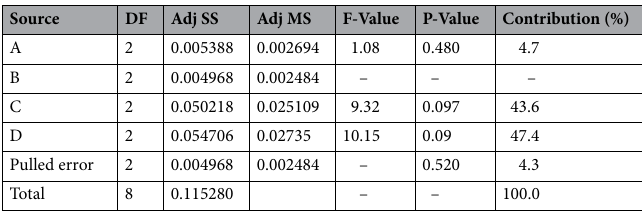
imply no interaction. So according to the figure, in all other diagrams except speed, there are no parallel trend lines and the directions are mixed. As a result of this strong evidence that the linear regression model is useless for GRG predictions, the response surface method’s linear-interaction model is used. Using a linear-interaction model of RSM, a multi-objective function for GRG was constructed and nominal terms have been removed from the equation 37,38 . Regression modeling of GRG . Response surface regression examines the correlation between variables, which deter- mines the relationship between GRG and process parameters. Also, the best responses can be achieved by finding the best correlation between factors and the best levels of parameters linear-interaction model of the response surface method is used. The regression model is shown in Eq. (11).